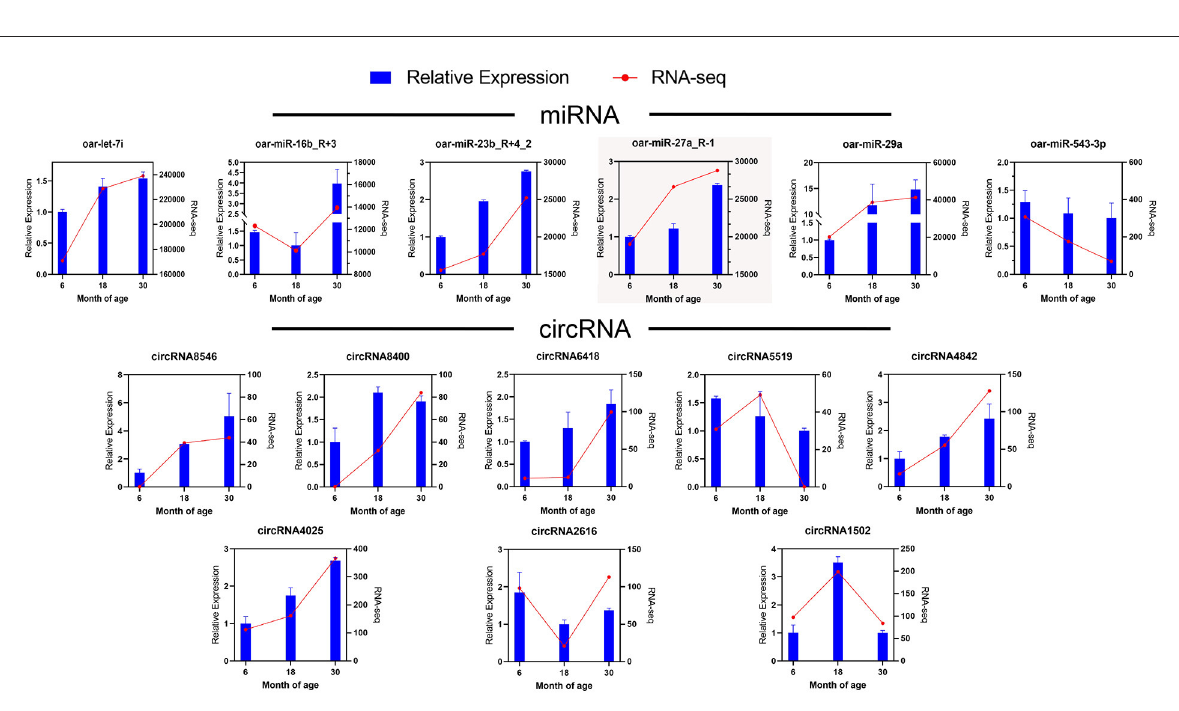
FIGURE4 Validation of DE miRNAs and DE circRNAs via qRT-PCR. The blue bar represents qRT-PCR data, and the red line represents RNA-seq